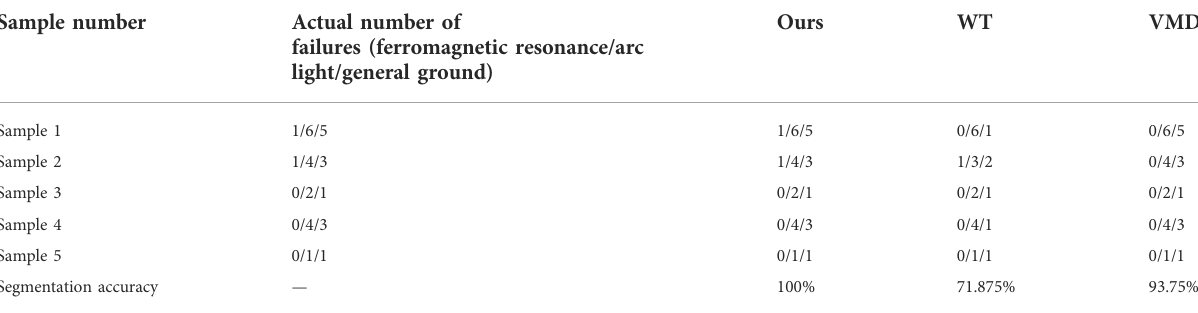
TABLE 8 Comparison of fault segmentation accuracy of different methods.